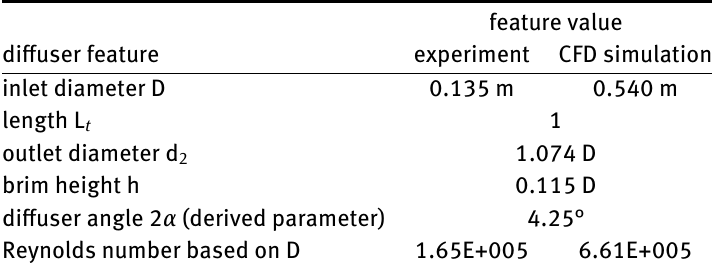
Table 1: Details of the diffuser model used in the numerical analysis.